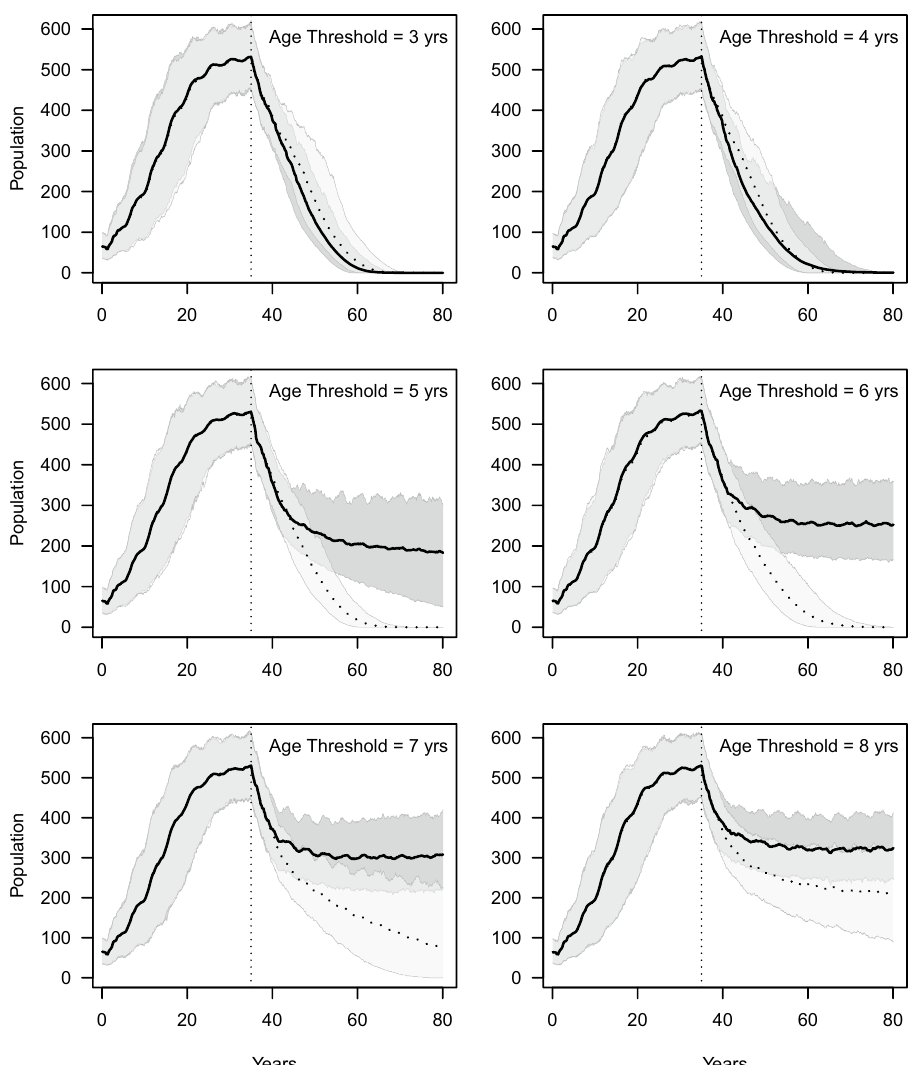
Figure 3. Effect of unreliable age assessment of hunted lions by professional hunters on lion population persistence for minimum age thresholds of ≥ 3 to ≥ 8 years (based on ageing data reported in 30 ). Simulations used an annual hunting quota of 18 males (~ 1.2 lions/1000 km 2 ) and a monthly conflict mortality rate of 0.4% with no edge effect. Curves with solid lines denote scenarios where ‘real’ ages of hunted lions were derived from the model and dotted lines incorporate age specific errors in age estimation by hunters. The black lines represent the mean and the light grey areas the 95% confidence interval of simulations. The vertical dotted line marks the point at which test scenarios were implemented after the population had reached its asymptotic state. After 45 years, populations in estimated age scenarios were the same or smaller than actual age scenarios (% difference between actual and estimated: ≥ 3 = 0, ≥ 4 = 0, ≥ 5 = − 100, ≥ 6 = − 99.9, ≥ 7 = − 80.0, ≥ 8 = − 33.6). See Figure S6 and S7 for expanded scenarios testing the combined effect of unreliable age assessment, edge effects and conflict